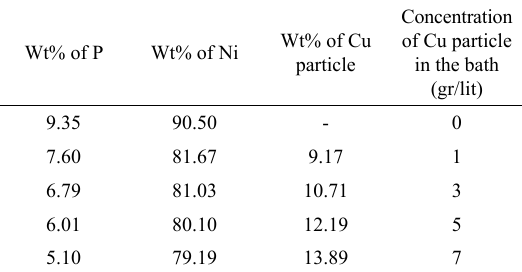
Table 9. Comparison of the effect of Cu particles concentration on the amount of Ni and P in the coating.